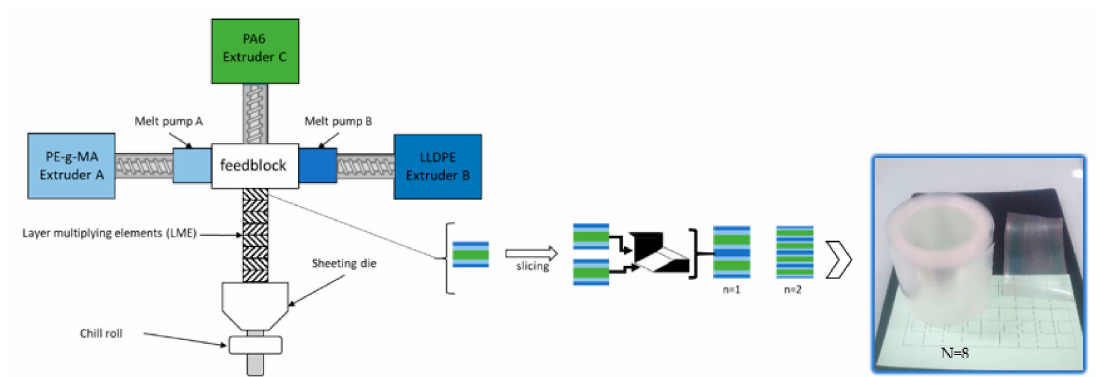
Figure 1. Schematic representation of coextrusion process ( left ); picture of a typical polyethylene (PE)/PEgMA/PA6 multilayer film using 8 LME ( right